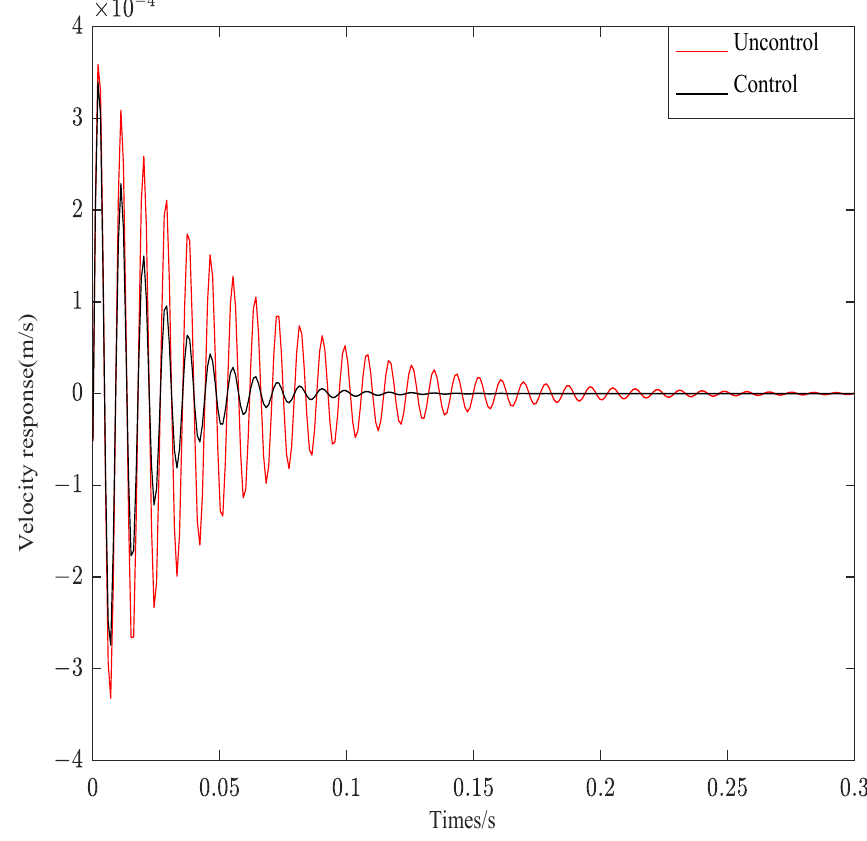
Figure 14 is the response curves of structure 3 under impulse signal.